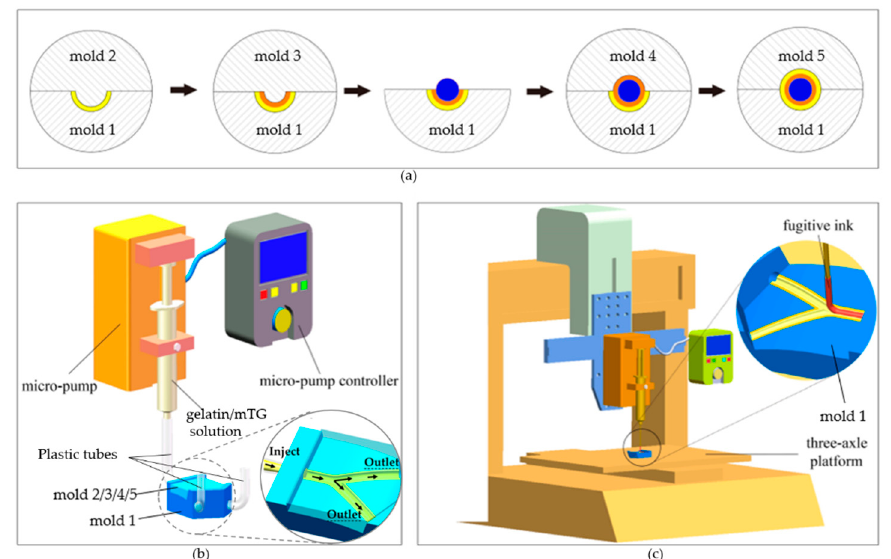
Figure 5. Fabrication process of the TEVG: ( a ) procedure of the step-by-step fabrication process. The molds 2–5 were gathered after mold 1 to compose the injection mold systems to form the different layers of the TEVG; ( b ) the gelatin/mTG perfusion system; ( c ) the fugitive ink printing system.